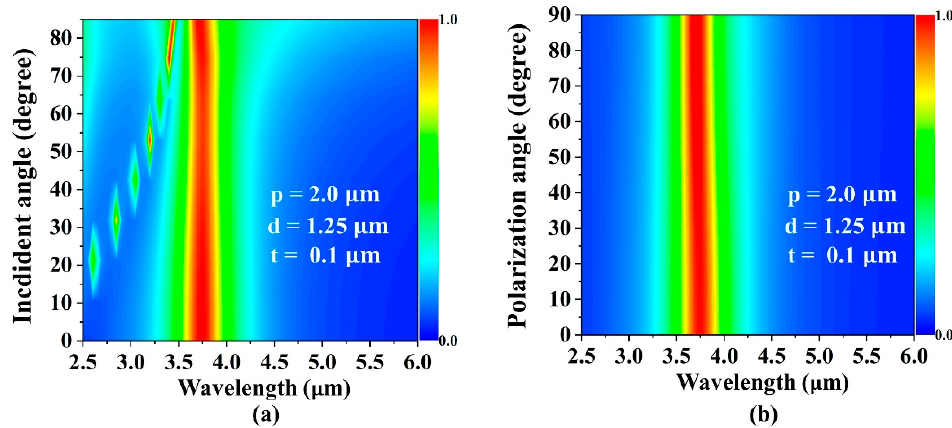
Figure 4. Simulated absorptivity spectrum as a function of ( a ) the incident angle and ( b ) polarization = 2.0 µ m, d = 1.25 µ m, and t = 0.1 µ m. angle for an absorber with p = 2.0 μ m, d = 1.25 μ m, and t = 0.1 μ m. angle for an absorber with p